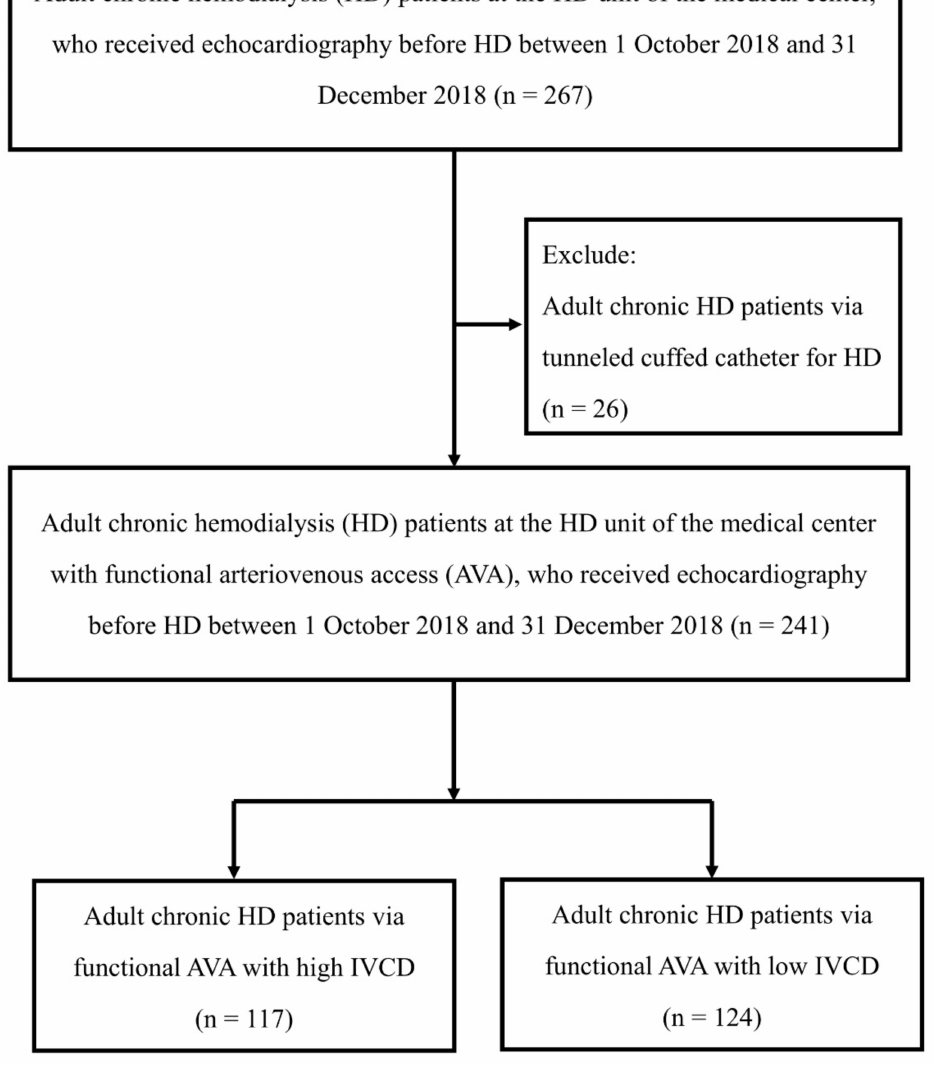
Figure 1. Flow of patient selection for the study cohort. HD, hemodialysis; AVA, arteriovenous access; IVCD, inferior vena cava